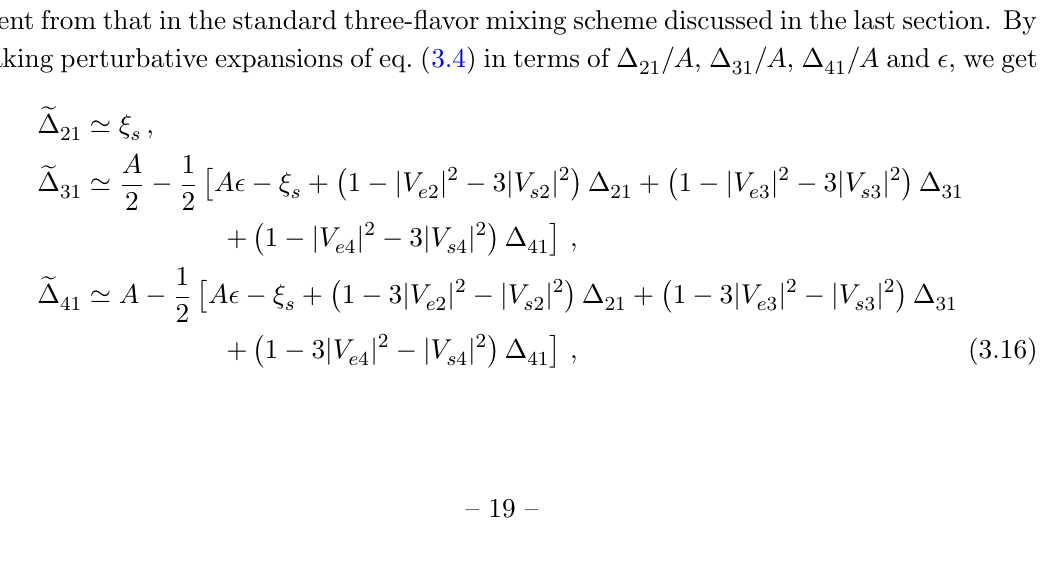
2 (for (cid:11) = e; (cid:22); (cid:28); s and i = V (cid:11)i j j ) with or without 3+1 e ; (cid:18) ; (cid:18) ; (cid:14); (cid:1) ; (cid:1) ) [36, 37], 12 13 23 21 31 ; (cid:18) ; (cid:18) ) = (6 : 66 (cid:14) ; 7 : 81 (cid:14) ; 0), (cid:14) = (cid:14) = (cid:14) = 14 24 34 14 24 34